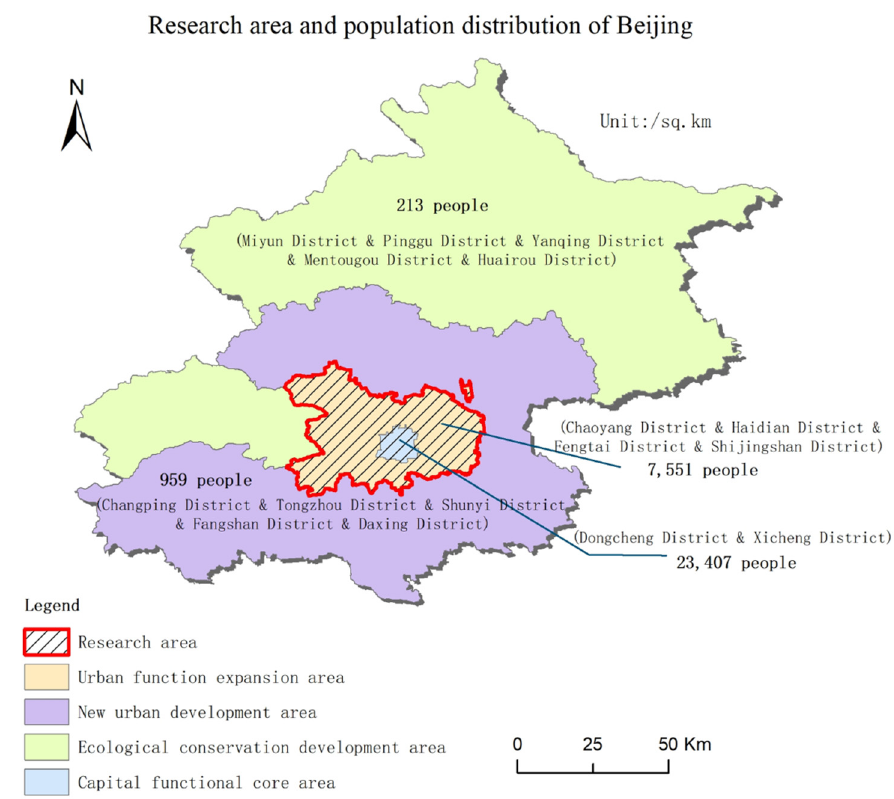
Figure 1. Research area and population distribution of Beijing.